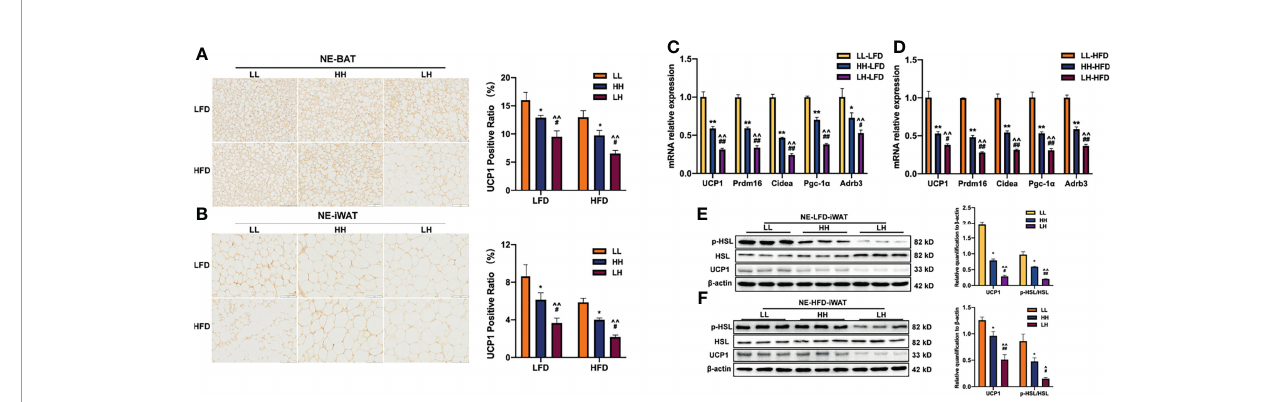
FIGURE 6 | Exposure to maternal HFD pre-weaning alone impaired the adaptive thermogenic function in BAT of adult offspring through SNS. UCP1 staining for BAT (A) or iWAT (B) sections of adult LL, HH and LH mice fed LFD or HFD (n = 3, from 3 litters) and UCP1 positive area after NE stimulation. mRNA expression of thermogenic genes in BAT when fed LFD (C) or HFD (D) (n = 3, from 3 litters). Western blot analysis for UCP1, p-HSL and HSL in iWAT of adult LL, HH, and LH mice fed LFD (E) or HFD (F) after NE stimulation (n = 3, from 3 litters). The fold increase was determined and normalized to b -ACTIN. Data are expressed as